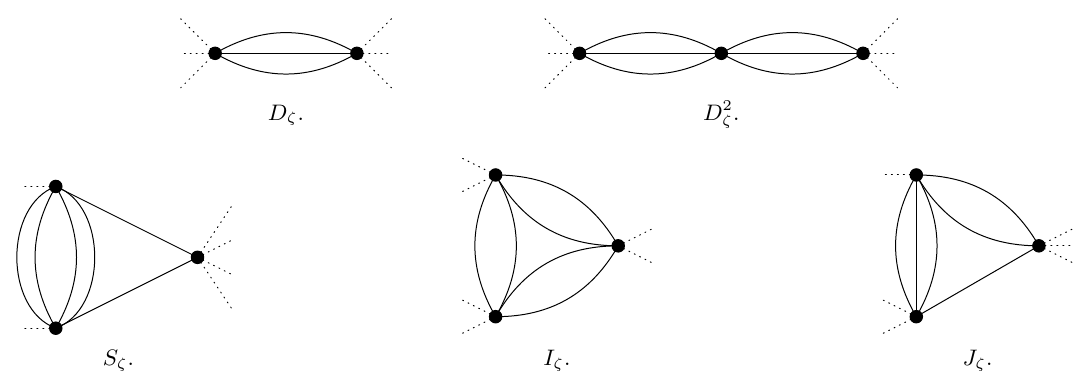
Figure 2. The five graphs contributing to the bare expansion up to order 3 in the coupling constant. For the short-range case, ζ = 1